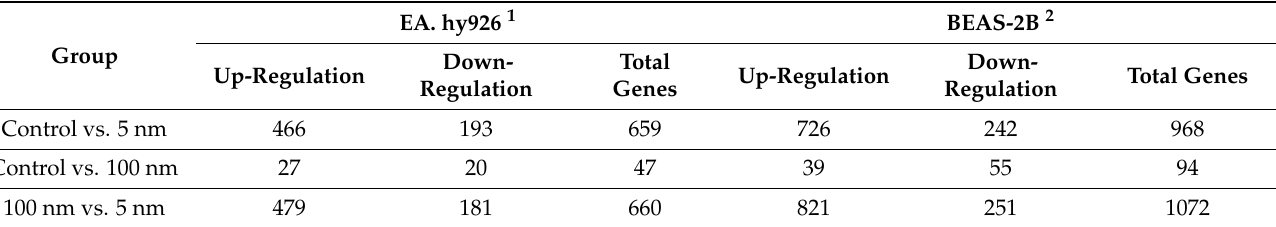
Table 1. Summary of differentially expressed